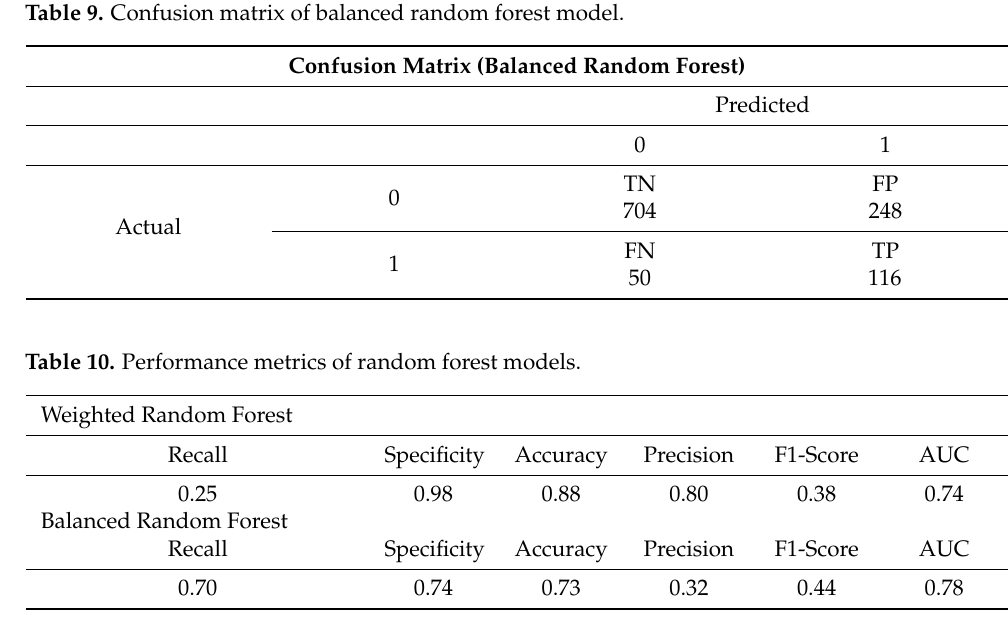
Table 9. Confusion matrix of balanced random forest model.